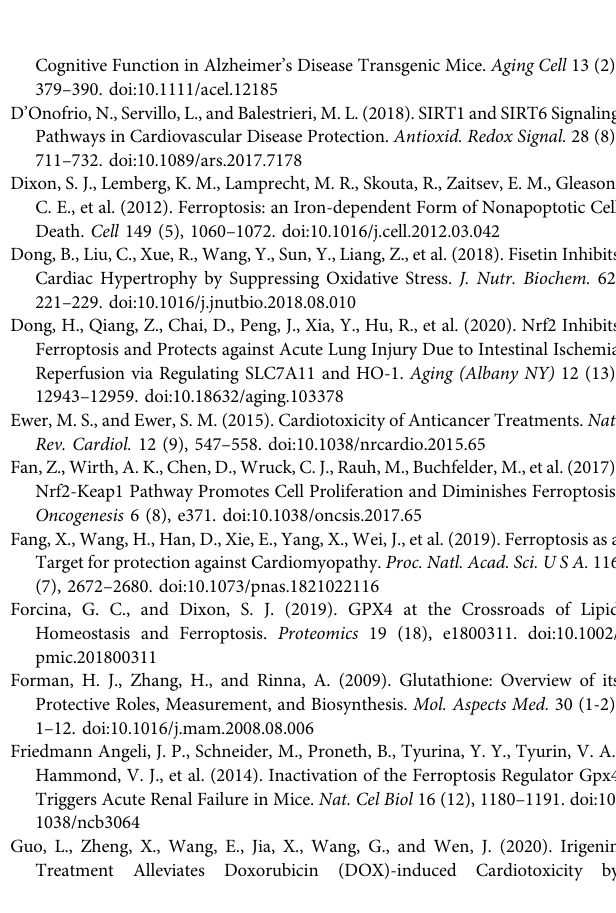
Supplementary Figure S1 | (A) Western blot results of GPX4, nucleus Nrf2, and cytosolNrf2proteinlevelsinH9c2cellsadministeredwithDOXorFer-1( n =4). (B – D) Quanti fi cation of (A) . The values are presented as mean ± SD. *** p < 0.001; SupplementaryFigureS2|(A-D) .MDA,GSH,ROS,andironconcentrationswere detected in H9c2 cells treated with DOX and/or fi setin, SIRT1 siRNA, respectively( n = 5). The values are presented as mean ± SD. *** p < 0.001; NS, no signi fi cance. Supplementary Figure S3 | (A-B) . Western blot results of Nrf2 protein levels after Nrf2 siRNA transfection. (C) . Western blot results of Nrf2, GPX4, SIRT1, HO-1, and FTH1 protein in H9c2 cells administrated with DOX and/or fi setin, Nrf2 siRNA. (D) . Quanti fi cation of Nrf2, GPX4, SIRT1, HO-1, and FTH1 protein analyzed by Image